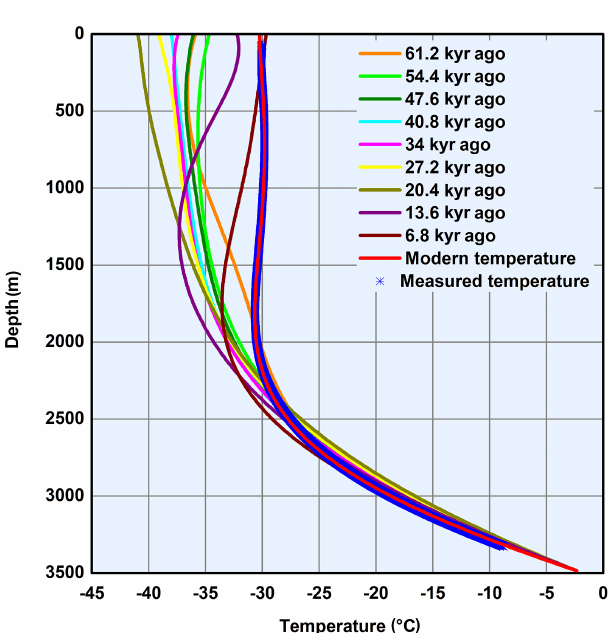
Figure 6. Paleo-temperature profiles at WAIS Divide based on tran- sient model ( m =